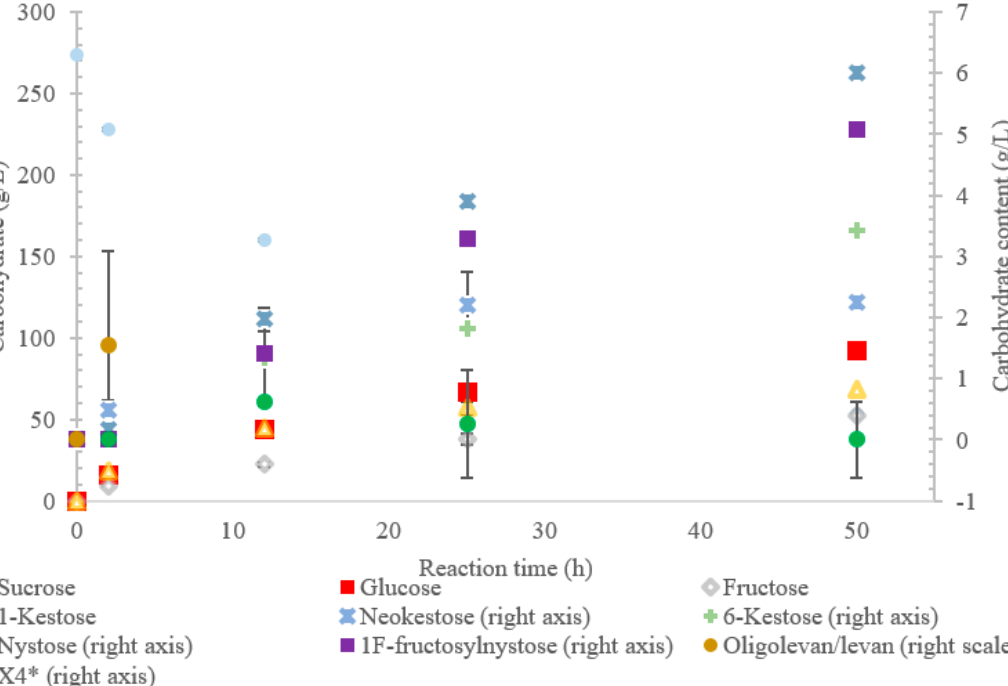
Figure 2. Reaction product profile of LS from Gluconobacter oxydans with sucrose for 50 h at 30 °C. *X 4 is a tetrasaccharide peak separate from nystose.